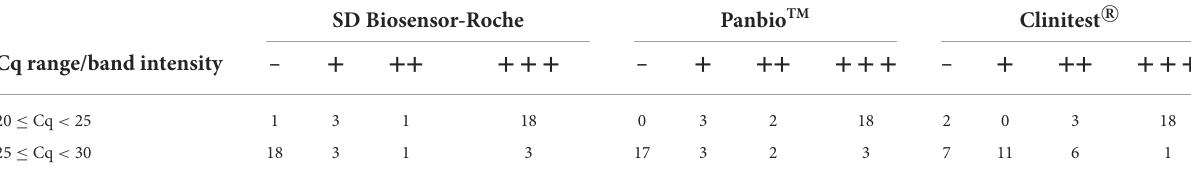
TABLE 2 Qualitative analysis of the band intensity obtained in the three RATs for the NPSs evaluated in the two Cq ranges. SD Biosensor-Roche Panbio TM Clinitest R (cid:13) Cq range/band intensity